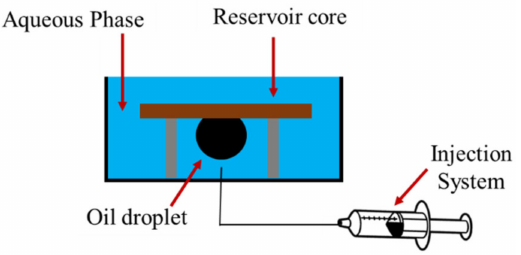
Figure 4. Schematic diagram of contact angle experimental